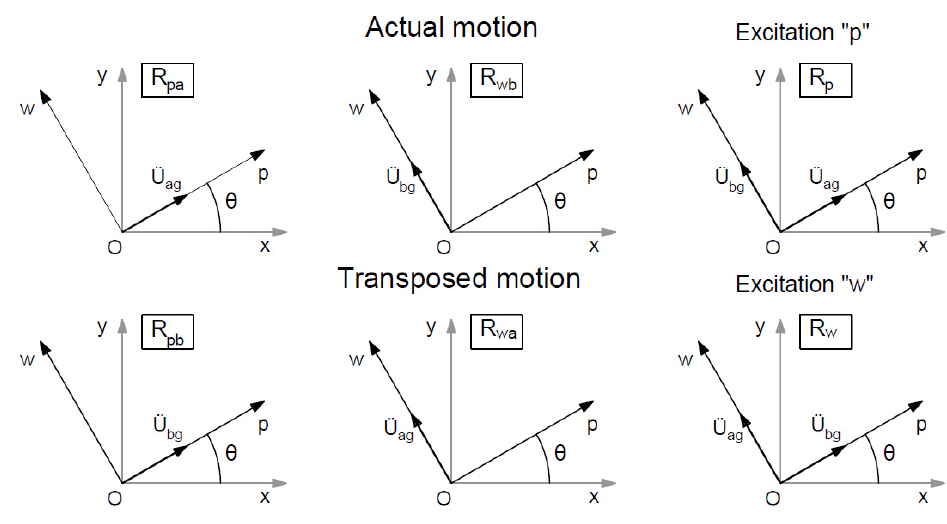
Figure 3. Displacements with respect to reference axis ( p , w ) [26].